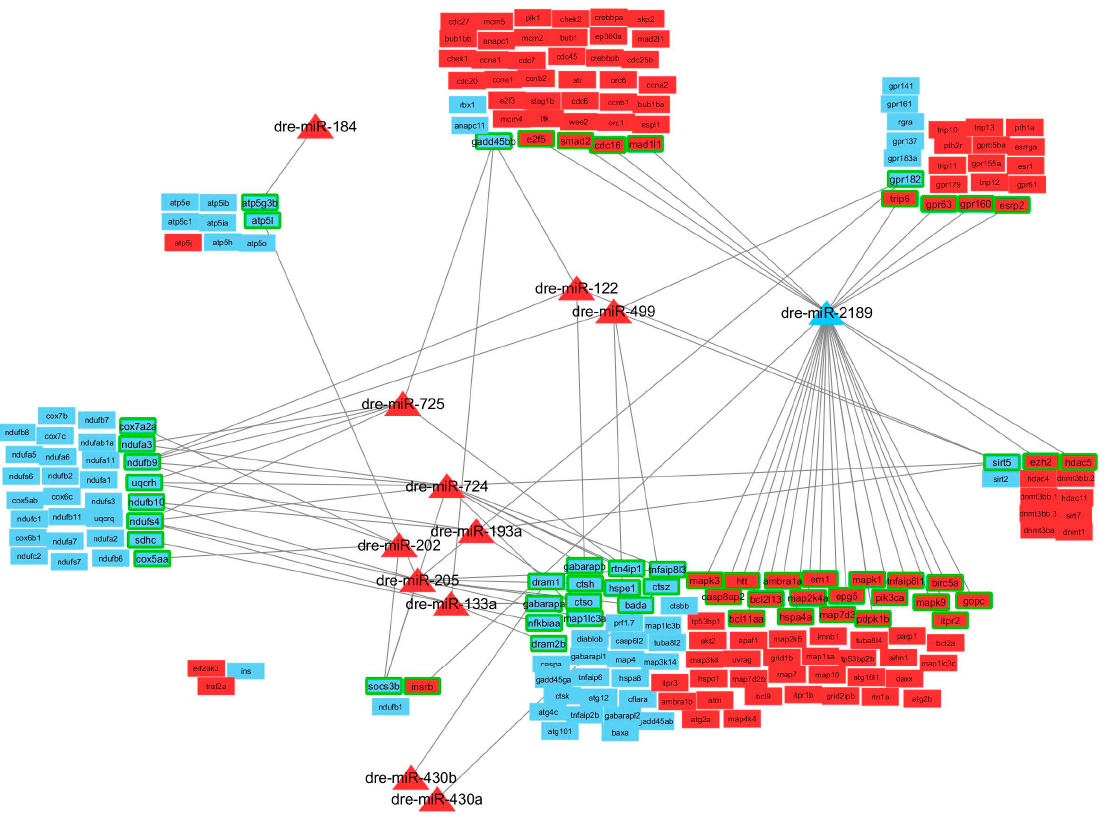
Figure 10. Network of miRNAs, targets and modules. The miRNAs that are upregulated after BPA exposure (positive fold change (FC)) are shown in red triangles, except dre ‐ miR ‐ 2189 which was the only downregulated miRNA (negative FC, shown in blue triangle). Each DE gene (q ≤ 0.1) present in a module are represented by either a red or blue box based on whether they were up ‐ or down ‐ regulated in the liver after BPA exposure (based on FC values). Genes that are predicted targets of miRNAs are outlined in green. For upregulated miRNAs, only predicted target genes with a negative FC are shown, and for downregulated miRNA (dre ‐ miR ‐ 2189), only predicted target genes with a positive FC are shown.